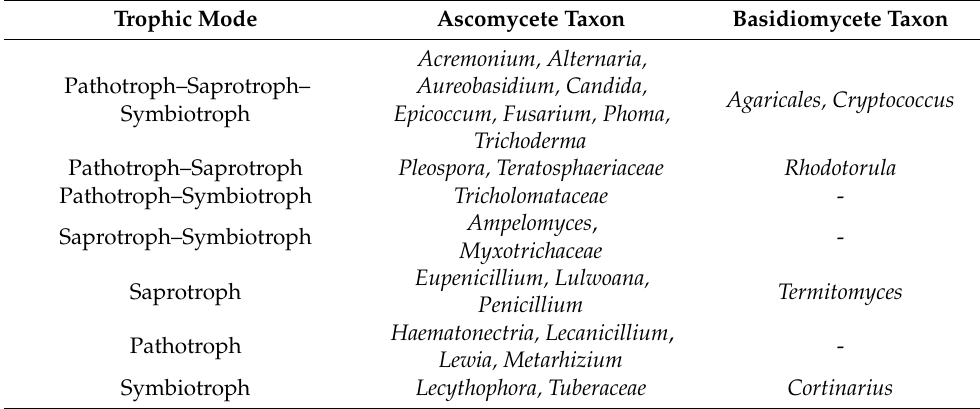
Figure 6. Venn diagrams indicating the number of unique and shared OTUs detected for the actinobac- terial communities ( A ) and the fungal communities ( B ); NR = Nuwejaars River system (developing peatland); GK = Goukou River system (impacted peatland); VV = Vankervelsvlei (undisturbed peatland). Table 5. Assignment of shared fungal OTUs to specific fungal trophic modes as determined using